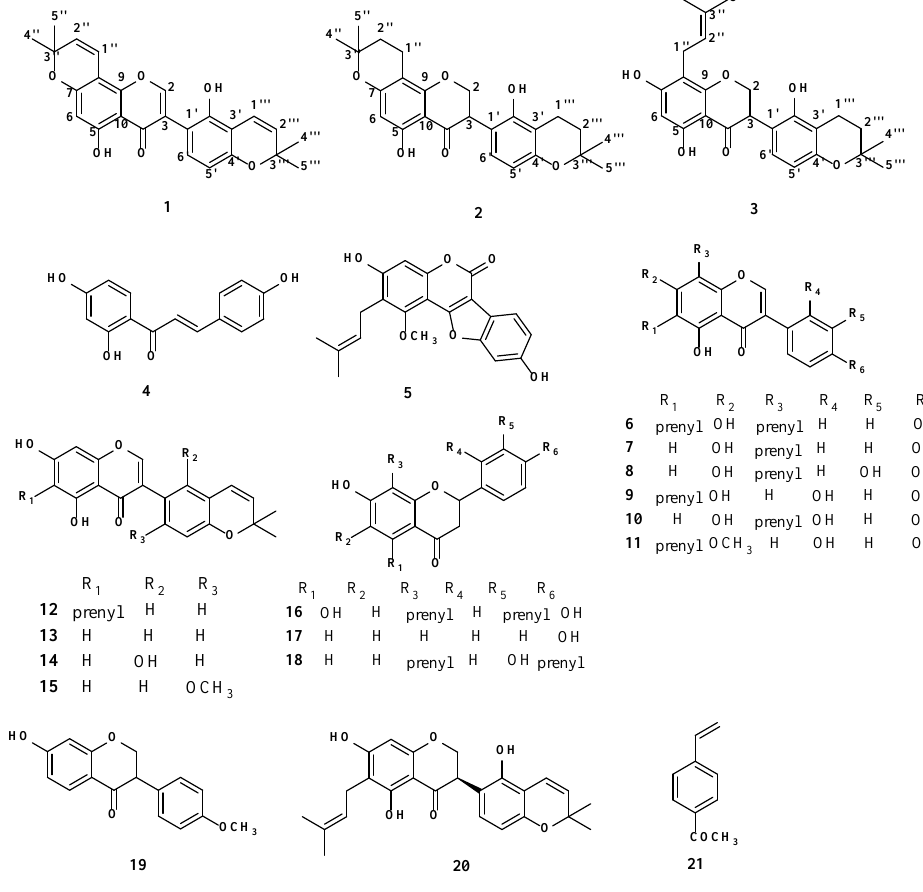
Figure 1. Structures of compounds 1 – 21 .